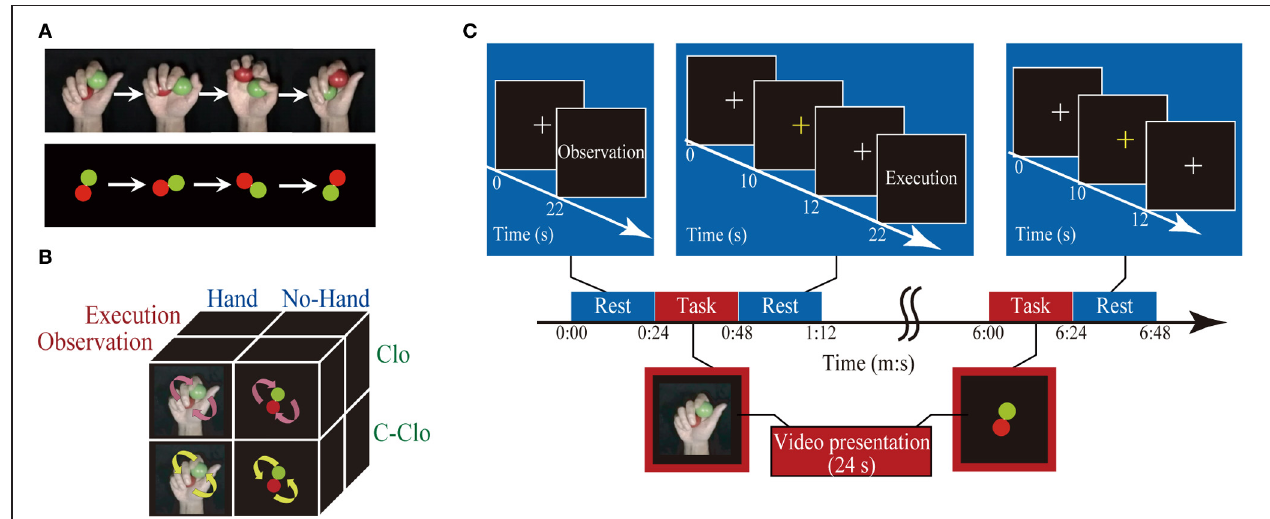
FIGURE 1 | Schematic diagram of an experimental run. (A) Sample frames of visual stimuli: clockwise rotation of two balls with a hand (upper row) and without a hand. (B) Schema of factorial design: arrows indicate the direction of ball rotation. (C) Schematic diagram of an experimental run: the rest and task conditions, each 24s in duration, were presented alternately. The first rest epoch comprised presentation of a white fixation crosshair, and instruction on the subsequent task (Execution or Observation)